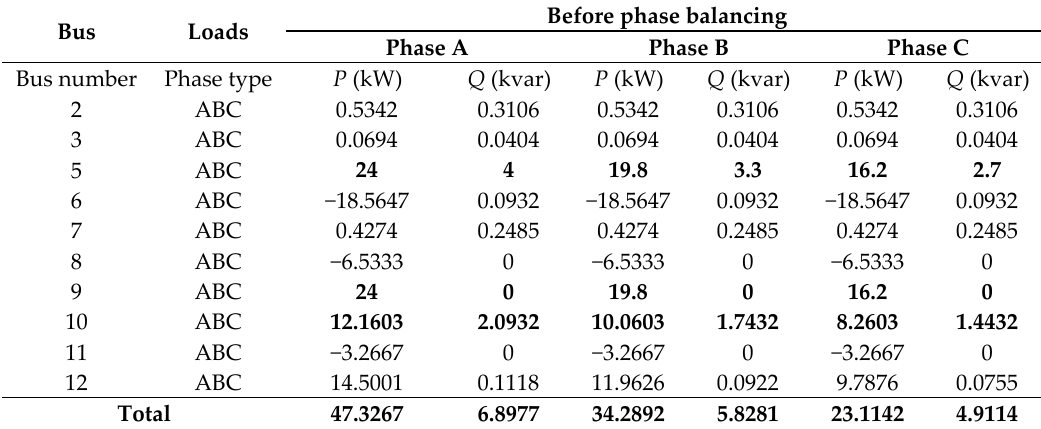
Figure 10. Optimal network reconfiguration function in energy management system (EMS) of the INER microgrid. Table 4. Individual phase loads of a weekday in summer before and after phase balancing at each bus of the INER